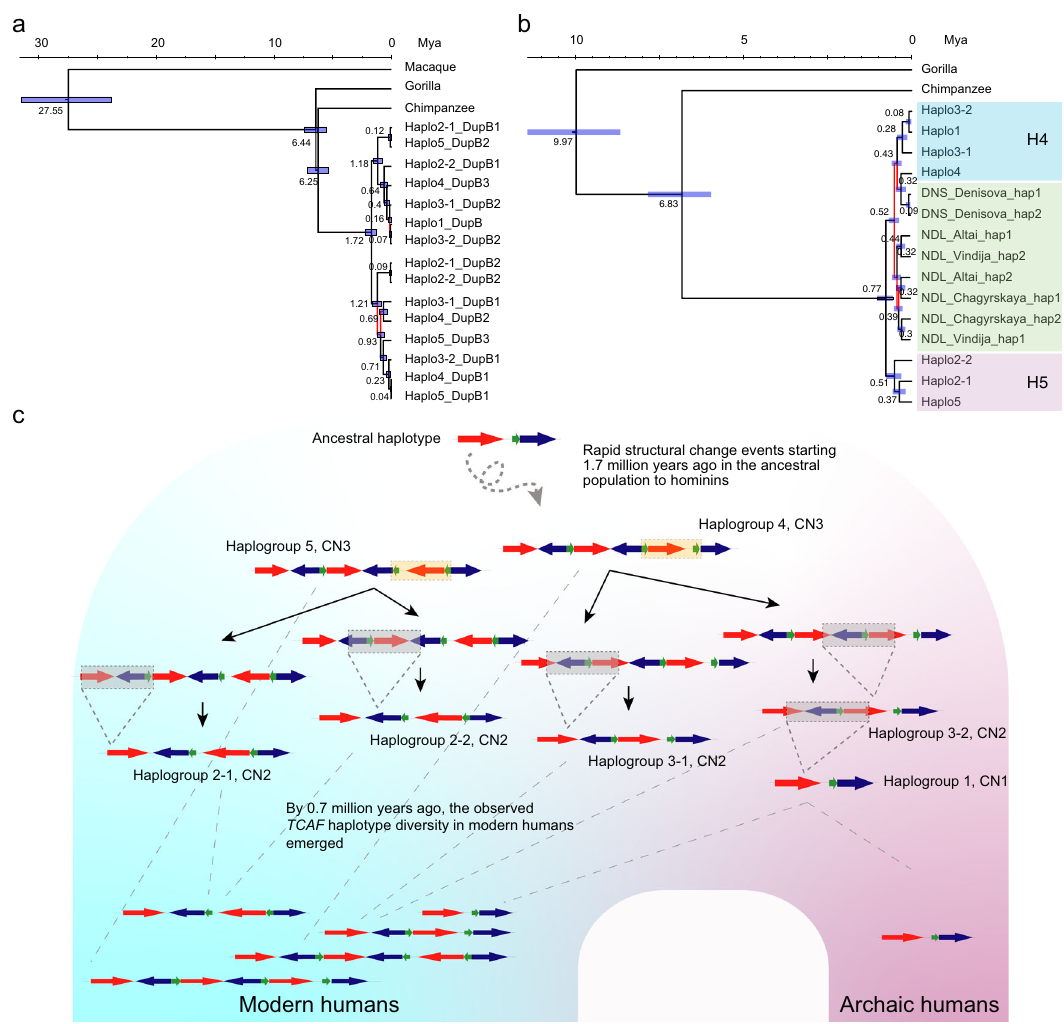
Fig. 4 Evolutionary reconstruction of TCAF structural diversity. a Phylogeny of the haplogroups was inferred using TCAF DupB sequences and BEAST (v.2.6.2) with fi ve independent runs of 10 million iterations of Markov Chain Monte Carlo (Methods). Numbers and horizontal bars at internal nodes indicate point estimates and 95% highest-posterior density intervals for the divergences (in million years ago, Mya), respectively. Branches with posterior probabilities <90% are colored in red. See Supplementary Figs. 22 – 24 for results of other SD sequences. b Inferred phylogeny of the modern human haplogroups and archaic hominin haplotypes using the 12 kbp unique sequences embedded within TCAF SDs (Fig. 1). Haplotypes of archaic samples were generated using high-con fi dent single-nucleotide variants (SNVs) called within the unique diploid region. Phylogenetic inference was performed similarly as described above. c Schematic model for the evolution of TCAF haplotypes in humans based on phylogenetic inferences (Fig. 4a, b and Supplementary Figs. 22 – 24). Colored arrows are TCAF SDs; orange and gray areas indicate relative inversion and deletion events between haplogroups, respectively. Short dashed lines indicate putative breakpoints of structural changes between haplogroups, while the long-dashed lines illustrate lineage